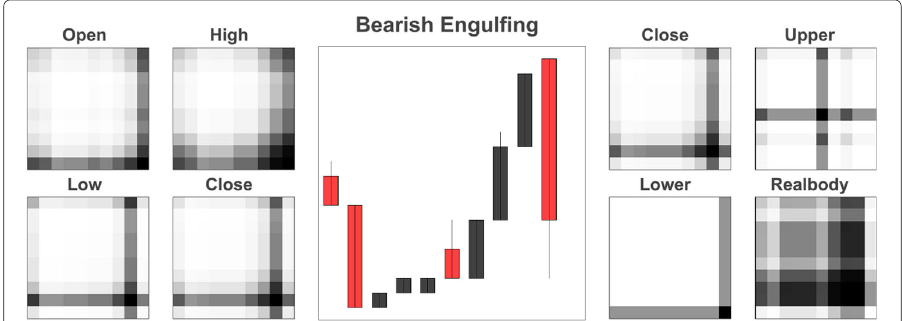
Fig. 10 Examples are the Bearish Engulfing patterns. The left-hand side shows the GASF features using